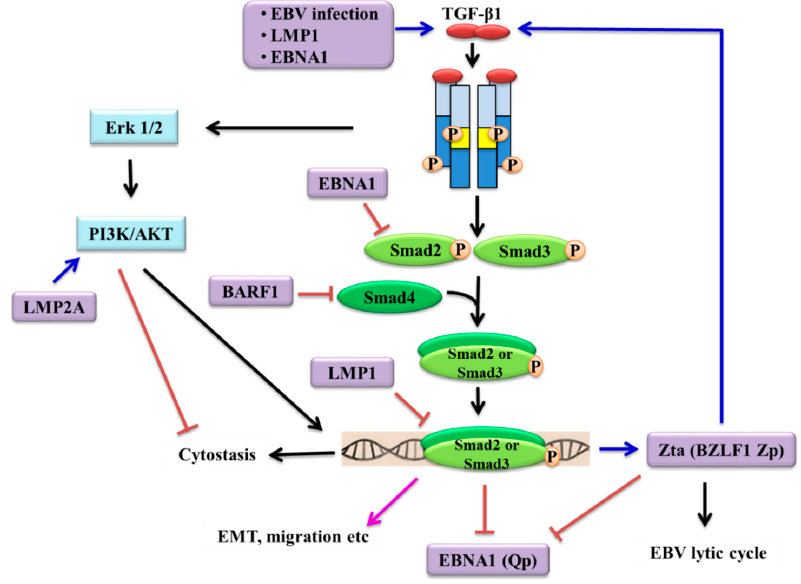
Figure 2. Modulation of TGF- β signalling by EBV. EBV infection or EBV-encoded latent proteins (LMP1 and EBNA1) can stimulate the expression and secretion of TGF- β 1 in epithelial cells. However, cancer cells often do not respond to the cytostatic effects of TGF- β , partly through the repression of signal transduction by the EBV-encoded proteins (EBNA1, LMP1, LMP2A and BARF1) through various mechanisms. The cancer cells often sustain a functional TGF- β core machinery and the excessive production of TGF- β drives aggressive malignant phenotypes. TGF- β signalling also appears to be crucial in regulating the balance between latent and lytic cycles in EBV-infected cells. TGF- β facilitates lytic reactivation in EBV-infected cells by stimulating the expression of BZLF1 /Zta via both Smad-dependent and Smad-independent pathways. Zta induces the production of TGF- β 1 which in turn, together with Zta, suppress the transcription of EBNA1 from Qp to disrupt EBV latency.